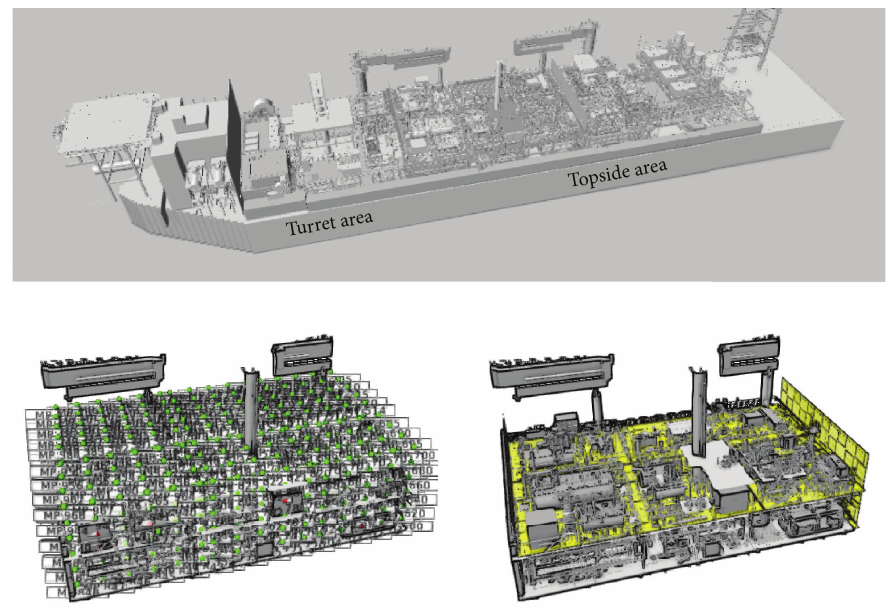
Figure 1: Separation of module and monitoring